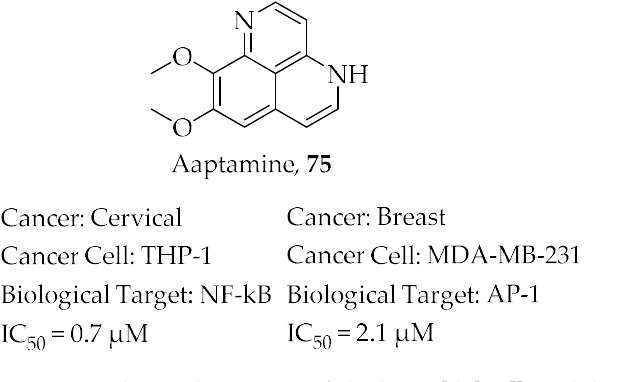
Figure 10. Chemical structure of the benzo[de [1,6]]-naphthyridine alkaloid Aaptamine with a sum- mary of its biological activity towards selected cancer targets.